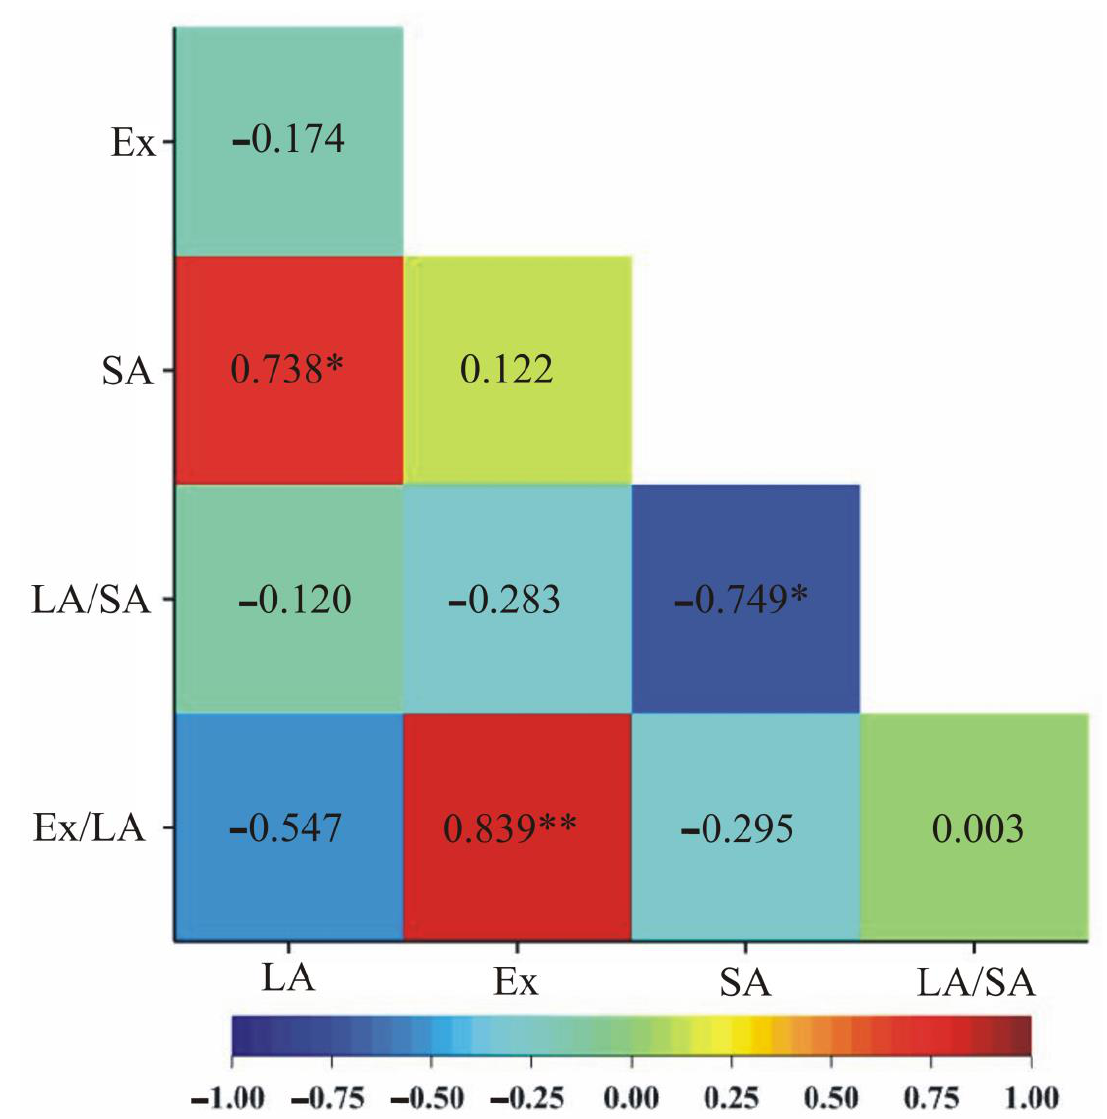
Figure 4. Heatmap for Pearson’s correlation coefficients between observed traits ( r cr = 0.666) for habitats. The heatmap shows a graphical representation of the correlation matrix between pairs of observed traits. LA: length of longest axis, Ex: thickness of exine, SA: length of shortest axis. * p < 0.05; ** p <